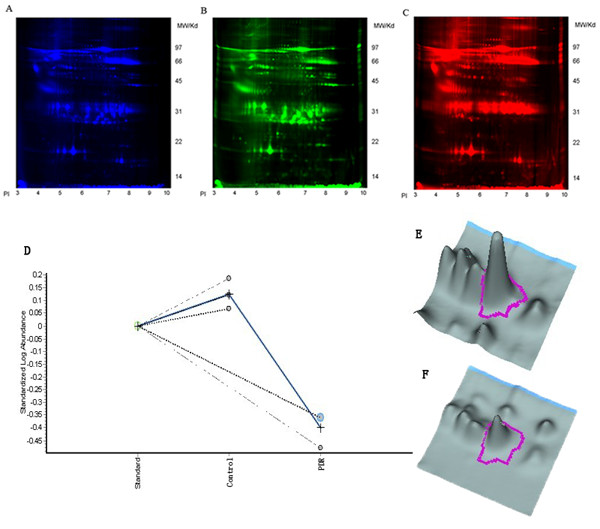
2-D DIGE images of the master gel (gel 1) and a graph view of spot 599. (A) Cy2 image from the internal standard. (B) Cy3 image from the control group. (C) Cy5 image from the PDR group. (D) The graph view showed the standardised abundance for spot 599 using DeCyder analysis. The blue line links the average abundance values for each group of samples. (E) 3D simulation view of DeCyder analysis for spot 599 in the control group. (F) 3D simulation view of DeCyder analysis for spot 599 in the PDR group.